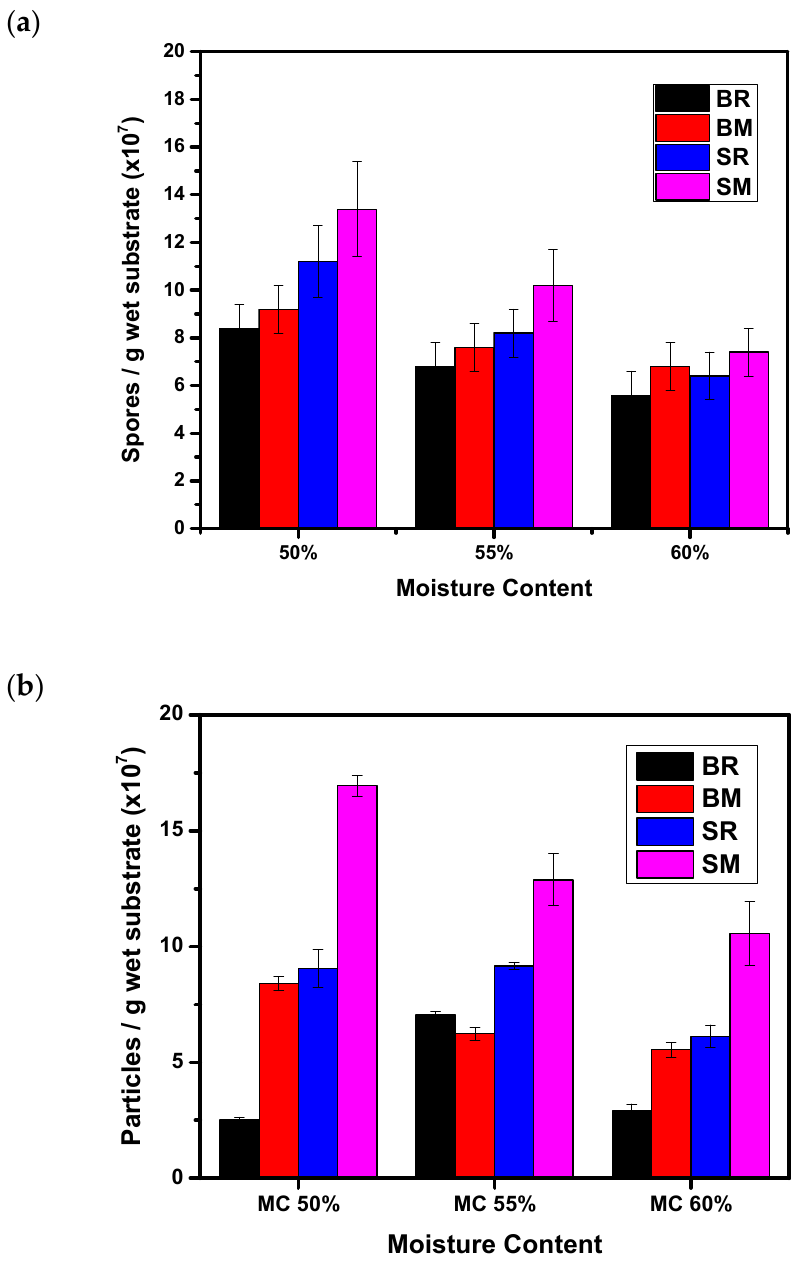
Figure 5. E ff ect of moisture content and substrate type (parboiled rice or millet) on spore production of B. pumilus and S. griseus enumerated after 360 hours of incubation using ( a ) traditional plate count method, and ( b ) flow cytometry counting R3 events in particles / g-wet-substrate (10 7 ) on each sample. Note: (BR) B. pumilus inoculated on rice; (BM) B. pumilus inoculated on millet; (SR) S. griseus inoculated on rice; (SM) S. griseus inoculated on